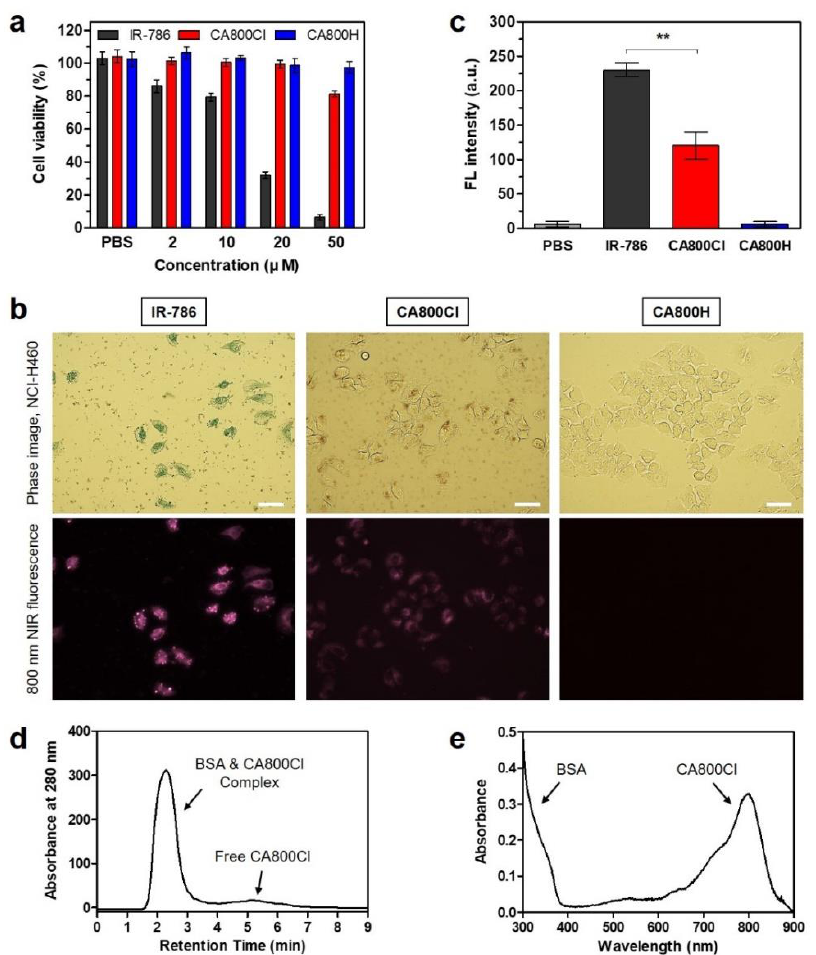
Figure 3. ( a ) Cell viability assay of each NIR fluorophore using NIH/3T3 cells. Percentage cytotoxicity is determined after 24 h of treatment with various concentrations of each NIR fluorophore. ( b ) Live cancer cell binding and ( c ) relative fluorescence intensity of each NIR fluorophore in NCI-H460 cancer cells. Phase contrast and NIR fluorescence images of cell line are obtained using 10 µM of each NIR fluorophore. Data are expressed as mean ± S.D. ( n = 3). ** p < 0.01. All NIR fluorescence images have identical exposure times and normalization. Scale bar = 100 μm. ( d ) GFC separation of a mixture of BSA and CA800Cl. The hydrodynamic diameter of BSA complex was measured at 280 nm using an absorbance spectrophotometer. ( e ) Absorption spectrum of BSA & CA800Cl complex. The sample was obtained from the first peak fraction as shown in ( d